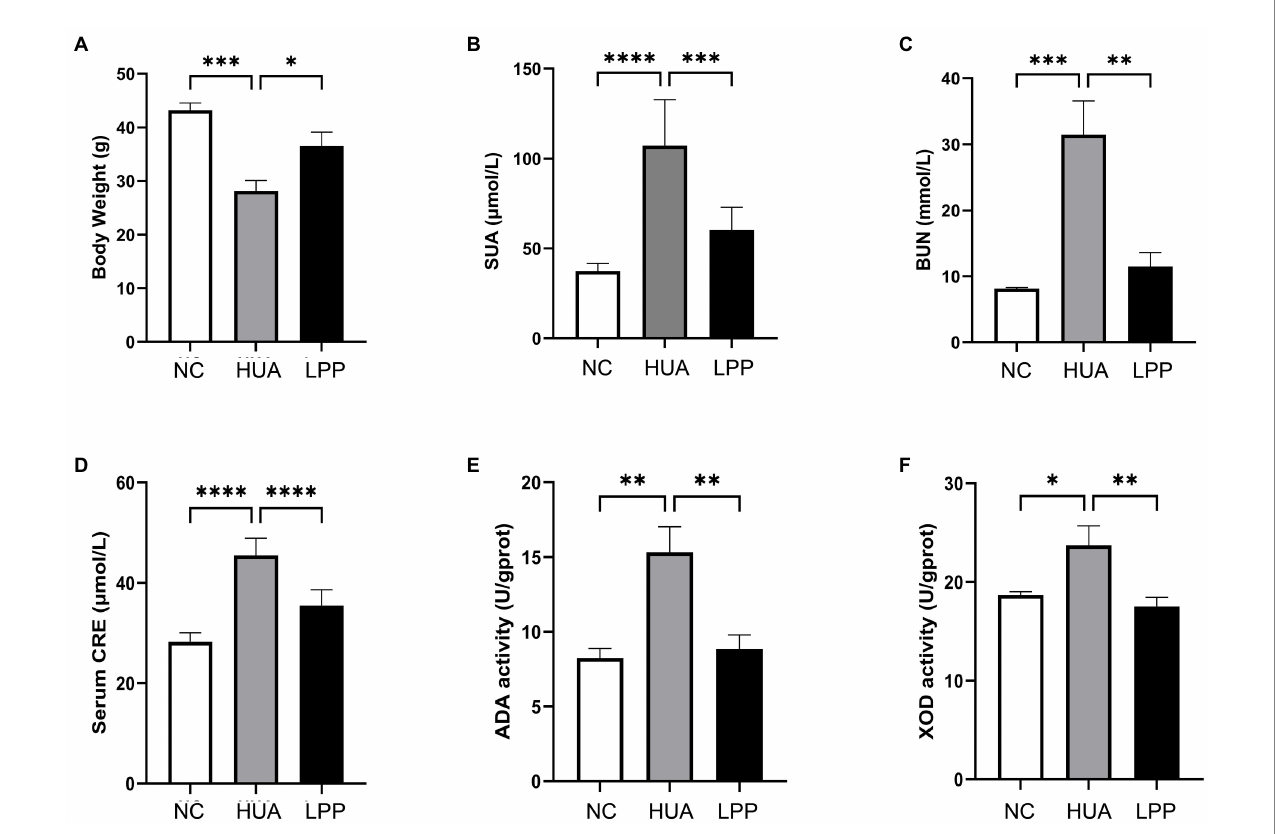
FIGURE 1 Effect of LPP on body weight (A) , levels of SUA (B) , BUN (C) , and CRE (D) , and activities of ADA (E) and XOD (F) in liver. NC, negtive control group; HUA, hyperuricemic group; LPP, hyperuricemic mice treated with LPP orally. Bars are means ± SD ( n = 6/group), p < 0.05 was set as the threshold for significance by one-way ANOVA followed by post hoc comparisons using Tukey’s test for multiple groups’ comparisons, * p < 0.05; ** p < 0.01; *** p < 0.001; **** p <